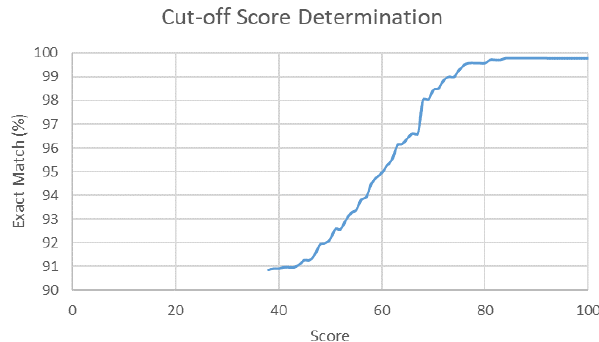
Figure 6. The user-defined cut-off score of 80 is chosen based on the results of the testing of different cut-offs on a smaller dataset within the YSGB area. As seen in this figure, the number of exact matches plateau at a score of